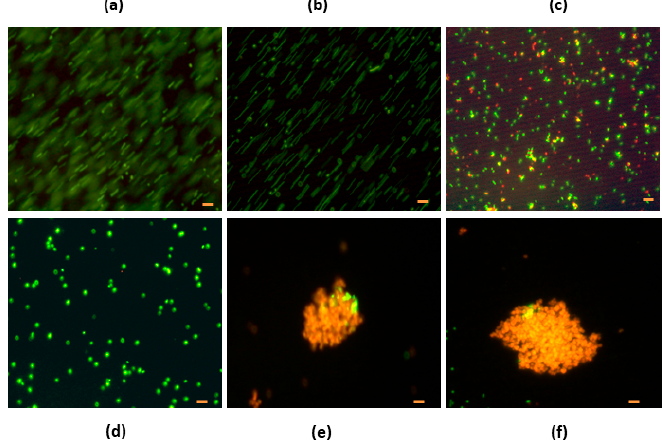
Figure 3. Escherichia coli and Staphylococcus carnosus incubated with native hen egg white lysozyme (HEWL) ( a ) E. coli control without HEWL, ( b ) E. coli with native HEWL (0.5 mg/mL), ( c ) E. coli with native HEWL (10 mg/mL), ( d ) S. carnosus (control without HEWL), ( e ) S. carnosus (0.5 mg/mL), and ( f ) S. carnosus with HEWL (5 mg/mL). Bar = 2 µ